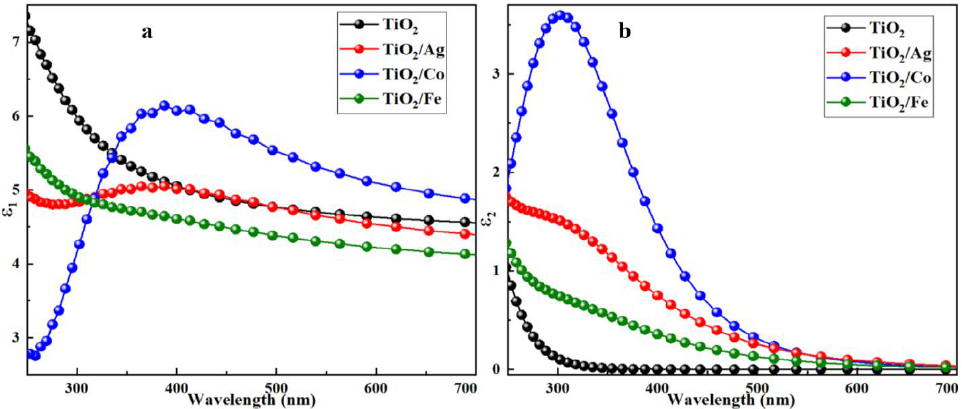
Figure 6. ( a ) Real and ( b ) imaginary parts of the dielectric function for pure and transition-metal- doped TiO 2.